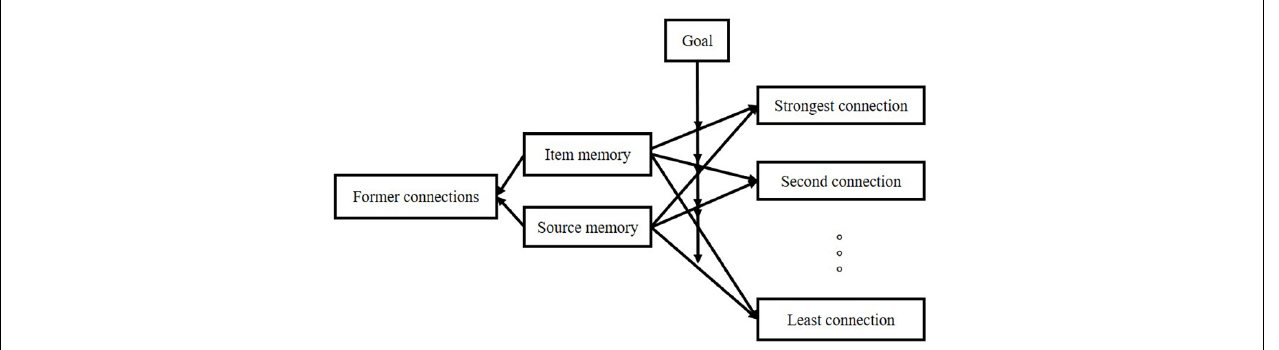
FIGURE 3 | A rough description of the “connection-strength model.”